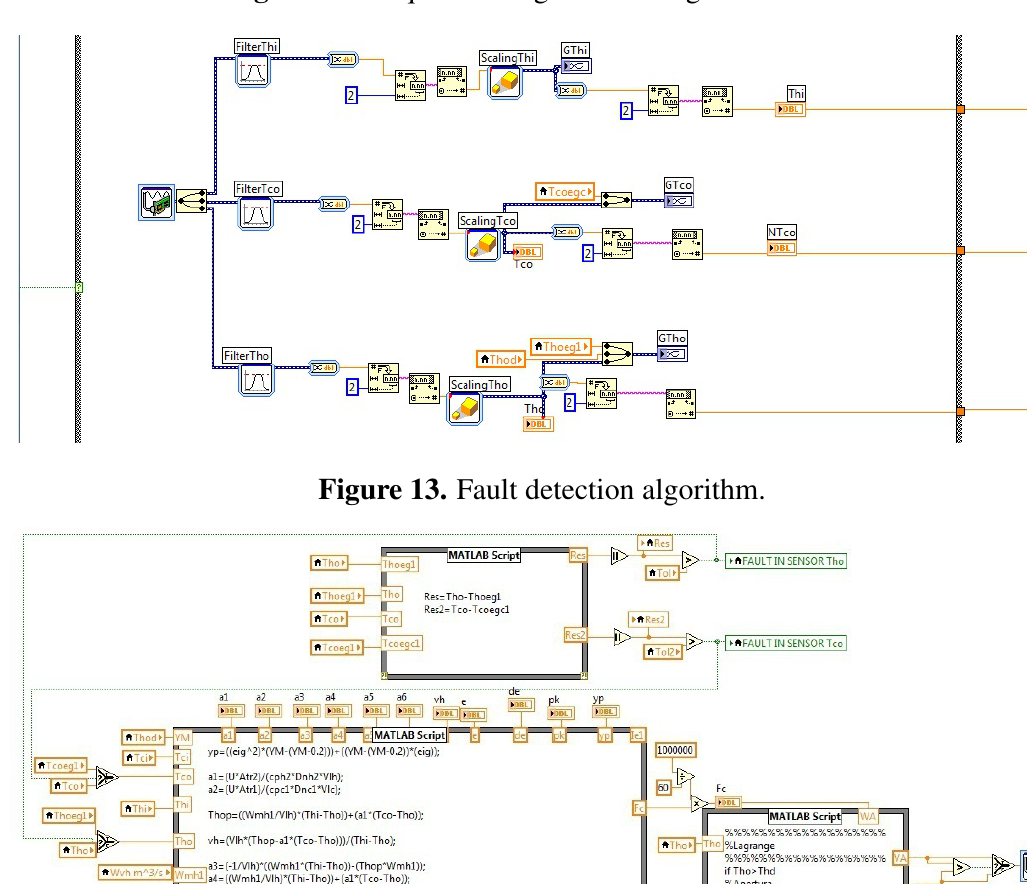
Figure 12. Acquisition algorithm using LabVIEW © .